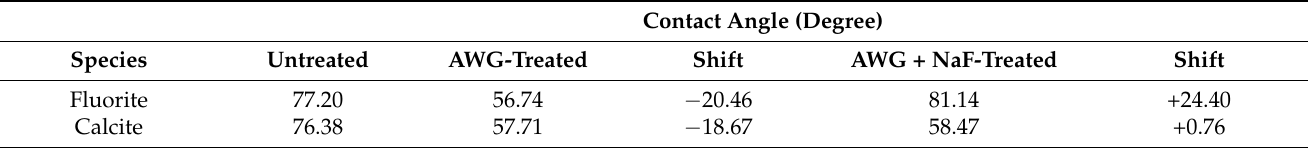
Table 6. Contact angle between fluorite surface and calcite surface treated with different